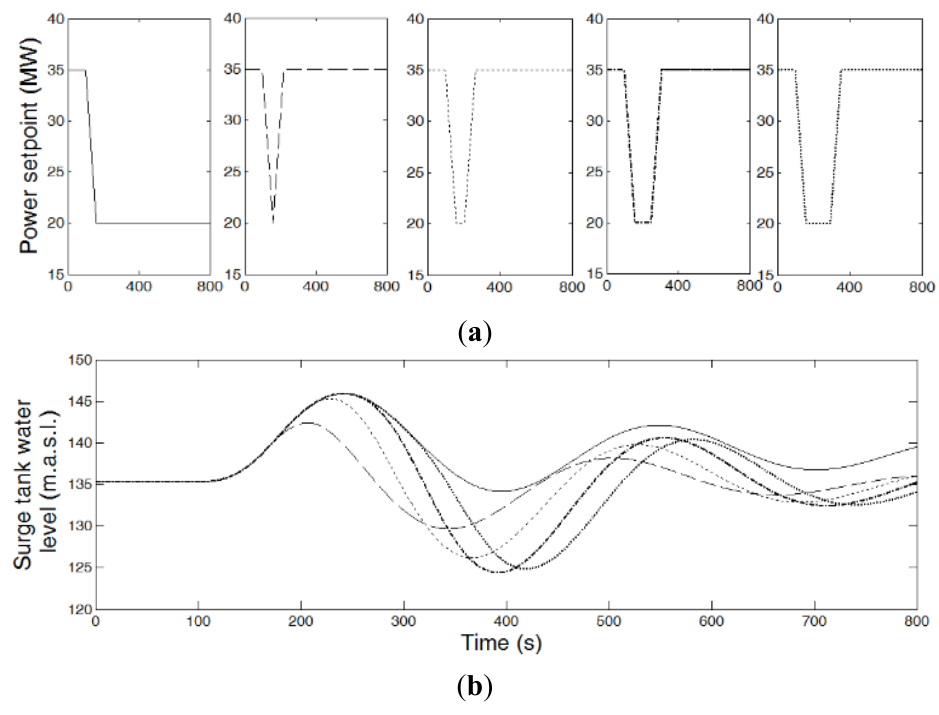
Figure 8. Evolution of the surge tank water level in response to different sequences of down- and up-ward power set-point ramp signals: ( a ) sequences of power set-point signals; ( b ) evolution of the furge tank water level in response to the power set-point signals.